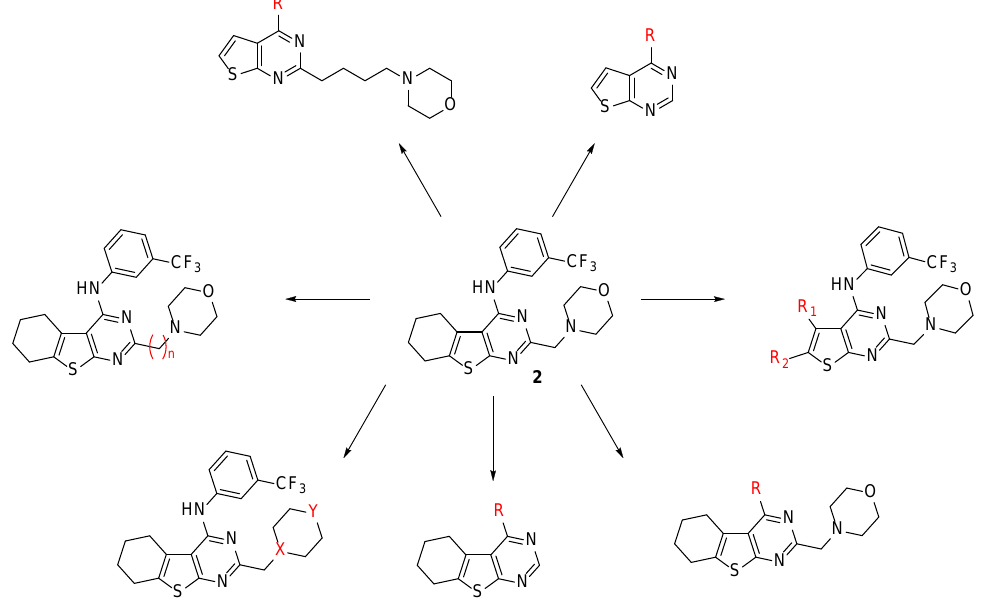
Figure 3. Derivatives of allosteric modulator 2 —directions of modifications.